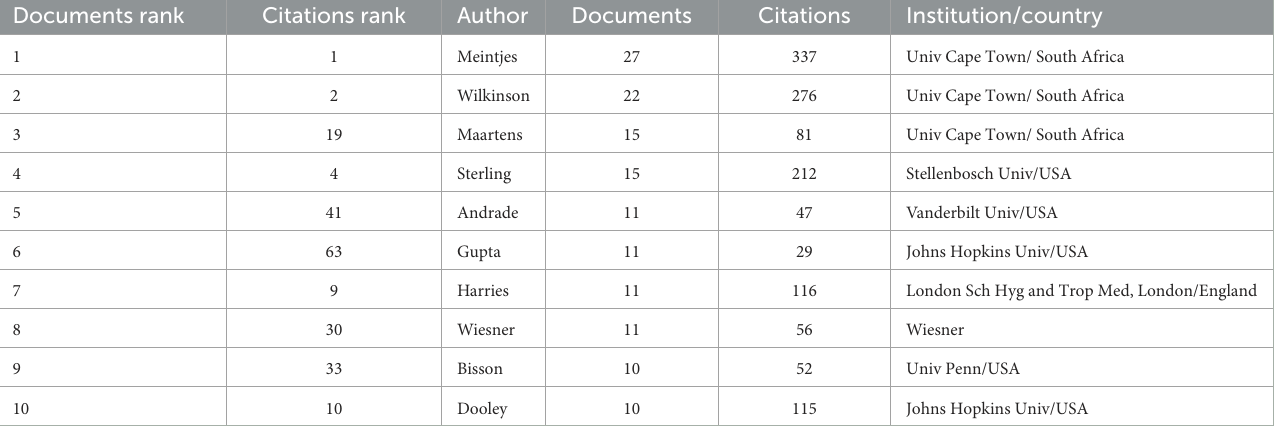
TABLE 2 The top 10 authors who contributed to publications about HIV-MTB co-infection.